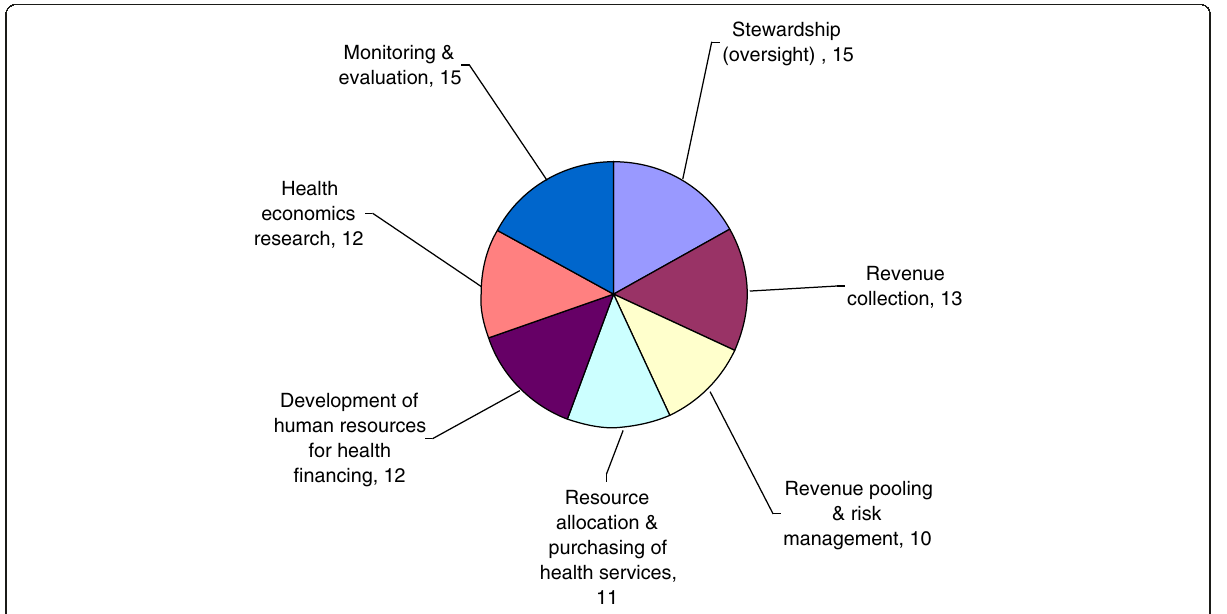
Figure 3 Number of respondents mentioning key components of national health financing